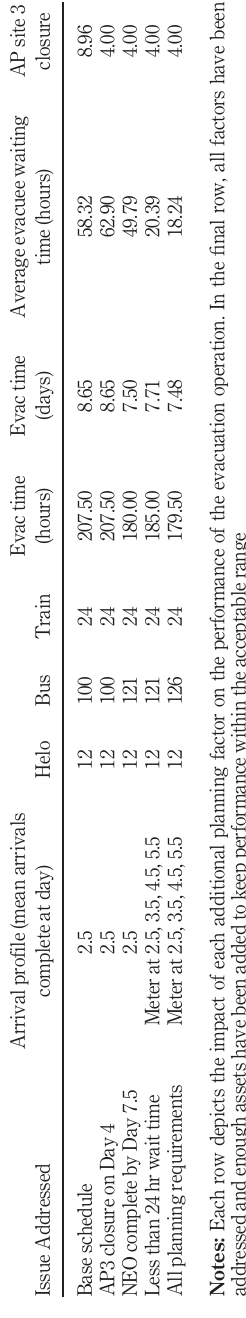
Table 2. Progression of the planning requirements